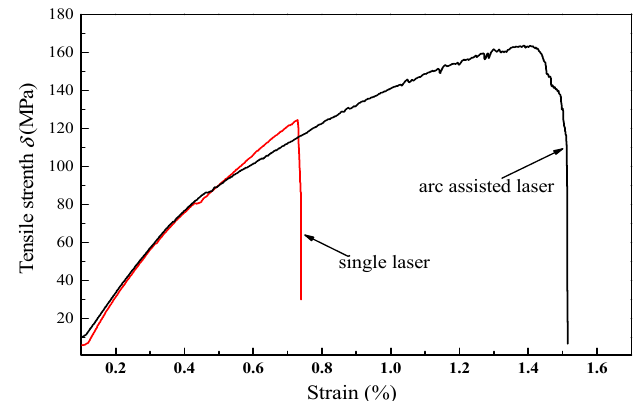
Figure 12. Engineering stress engineering strain curves of single laser welding and arc assisted laser welding.